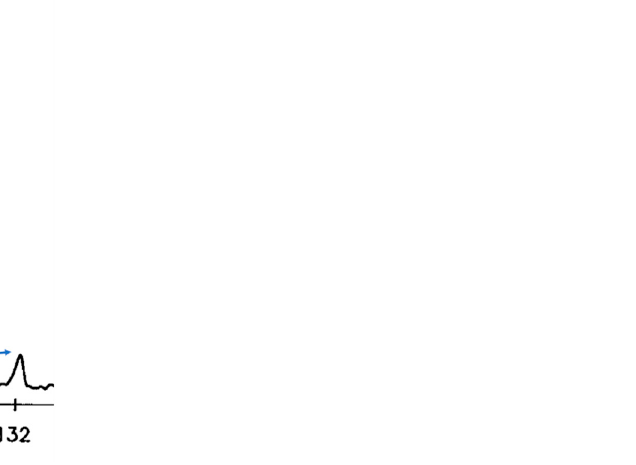
Figure 6. Time course of Rj in crayfish axons uncoupled by heptanol in the presence and absence of 20 mM theophylline. As with caffeine (Figures 2–4), theophylline dramatically increases Rj maxima with heptanol. Adapted from [16]. The possibility that the effect of caffeine or theophylline is due to an increase in cyclic nucleotides was tested by exposing the axons to 3-isobutyl-1-methylxanthine (IBMX, a phosphodiesterase inhibitor), forskolin (an activator of adenylate cyclase) or diffusible cAMP and cGMP (CPT-cAMP and 8Br-cGMP) [16]. Additions to heptanol of 1 mM IBMX (Figure 7), a phosphodiesterase inhibitor 200 times more potent than caffeine [22], 5 μ M forskolin, 500 μ M CPT-cAMP or 200 μ M 8Br-cGMP do not significantly affect Rj maxima [16]. The possible involvement of protein kinase C (PKC) was tested by superfusing the axons with heptanol solutions containing either 162 nM TPA (4 β -phorbol-12 β -myristate- 13 α -acetate) or 100 μ M H7 (1-(5-isoquinoliny sulfonyl)-2-methylpiperazine); neither TPA (an activator of PKC) nor H7 (an inhibitor of PKC) significantly affected the magnitude of heptanol-induced uncoupling [16].